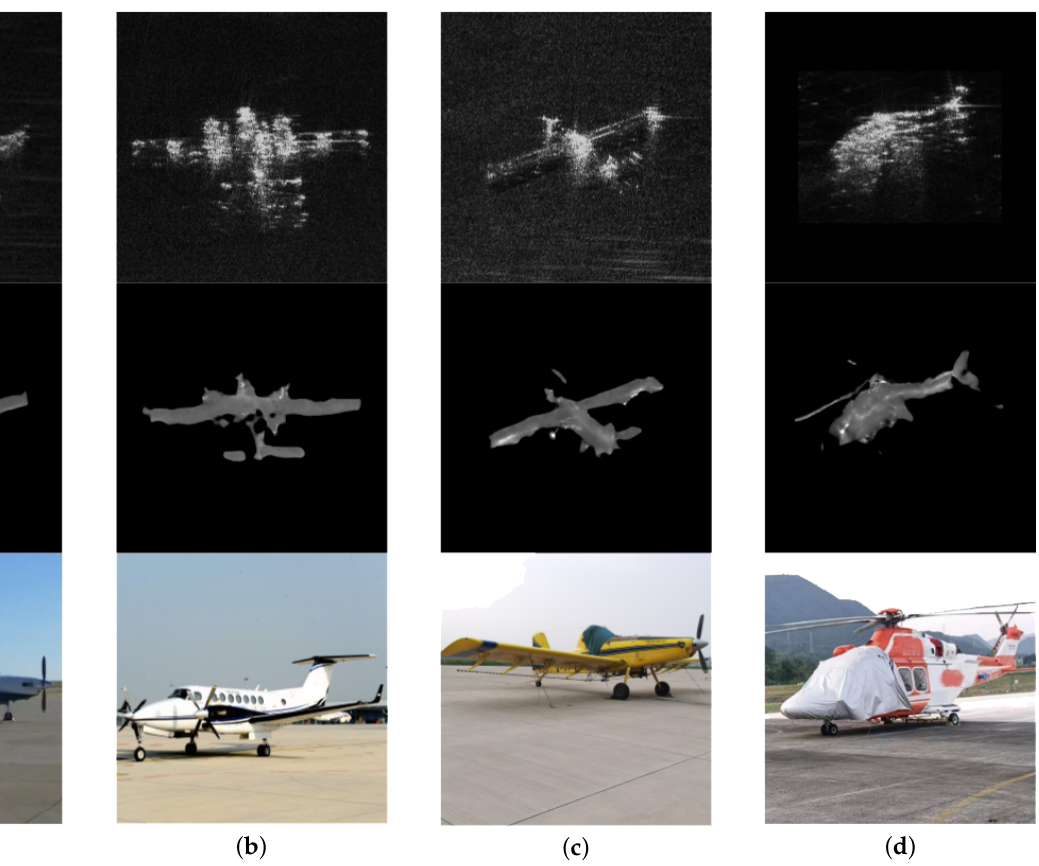
Figure 8. Translation results of extended aircraft types. Panels ( a – d ) show the results of PC-12, Beech King Air 350, AT-504, and AW 139, respectively. Images of each row from top to bottom belong to SAR images, translated images, and photos of the targets